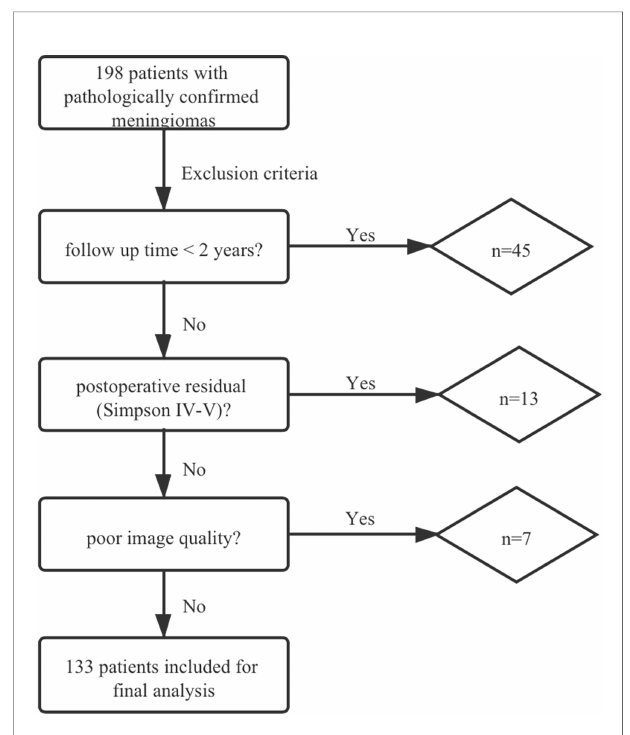
FIGURE 1 | Flowchart of the patient selection